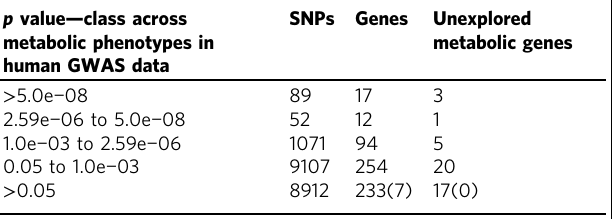
Table 2 Translation to human disorders p value — class across metabolic phenotypes in human GWAS